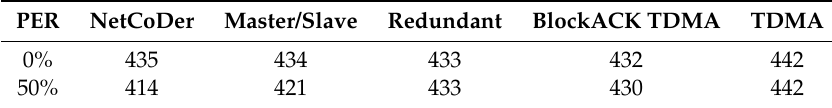
Table 3. Estimated lifetime of node (hours) for different PER.